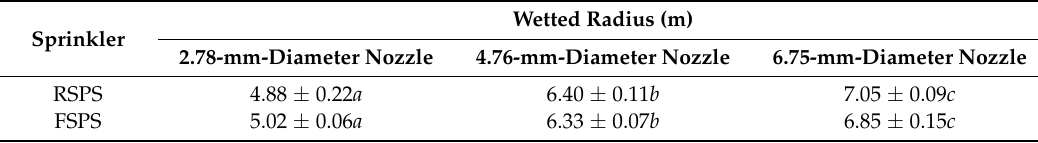
Table 5. Wetted radii of rotating spray plate sprinklers (RSPSs) and fixed spray plate sprinklers (FSPSs) with nozzles of differing diameters installed.